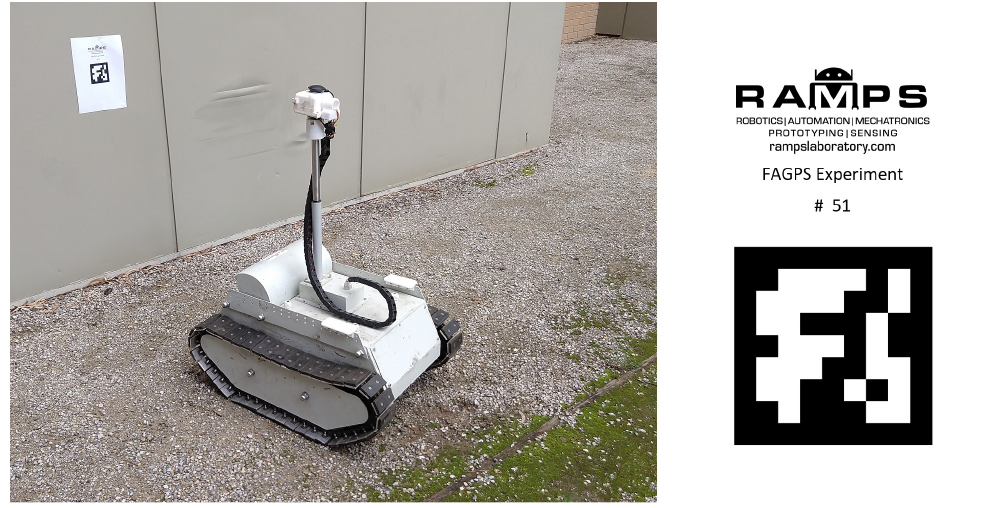
Figure 1. Robot performing visual pose estimation on a geolocated fiducial marker with fiducial shown on